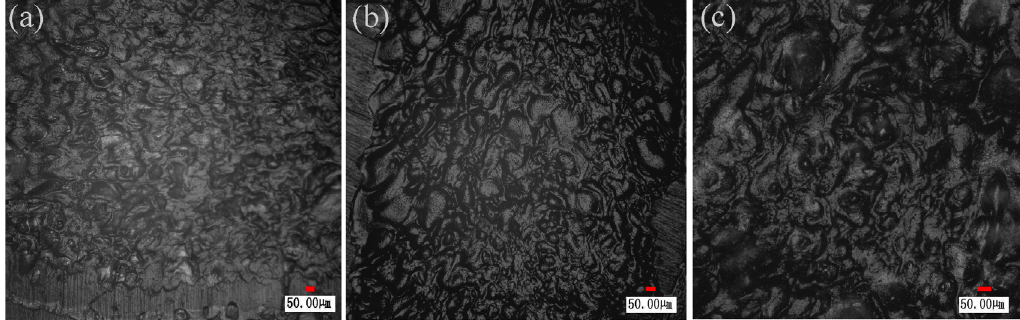
Figure 14. ( a ) The micro morphology of the weld zone on TGMPP when laser power is 20 W; ( b ) 35 W; ( c ) 50